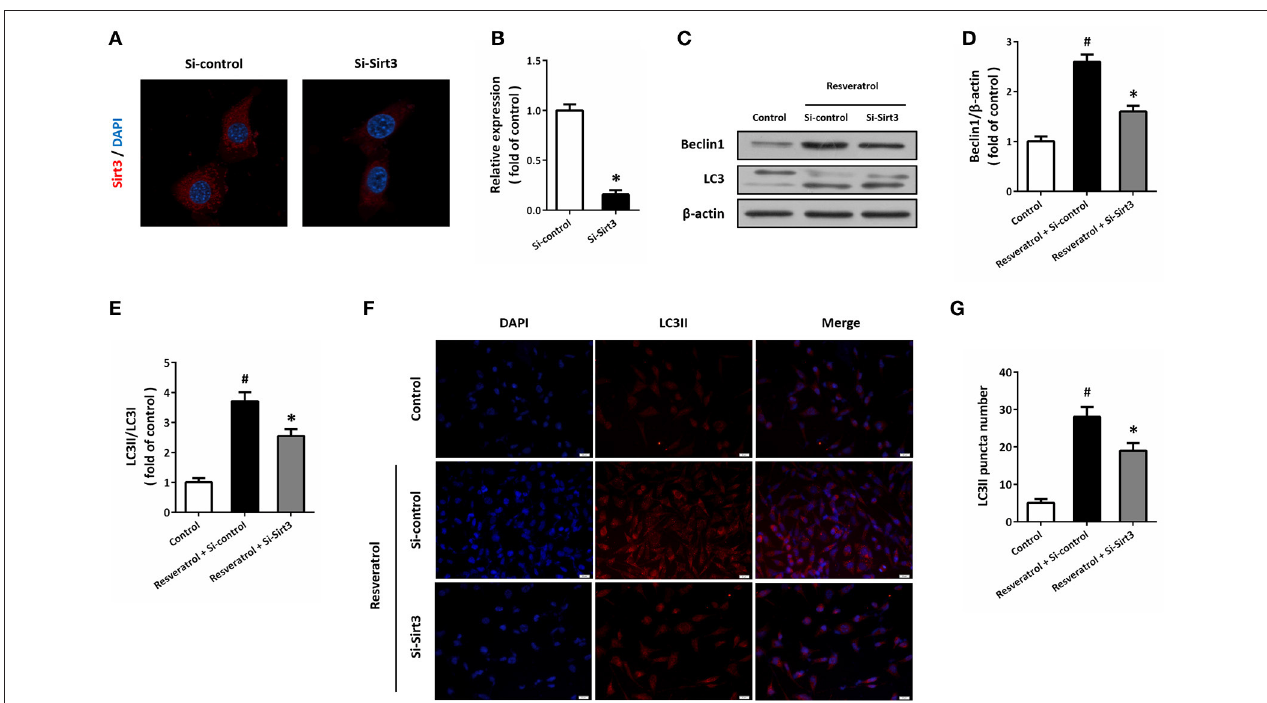
FIGURE 6 | Sirt3 activation contributes to resveratrol-induced autophagy regulation. HT22 cells were transfected with Si-control or Si-Sirt3 for 48h, and the expression of Sirt3 protein was detected by immunofluorescence staining (A) and calculated (B) . After transfection, HT22 cells were treated with resveratrol for another 24h, and the expression of Beclin1 and LC3 was detected by western blot (C–E) . Immunofluorescence staining of LC3II was performed to assess autophagy in HT22 cells (F) , and the number of LC3-positve puncta was counted (G) . Data are shown as mean ± SEM. # p < 0.05 vs. Control. * p < 0.05 vs. Si-control. Scale bar = 20 µ